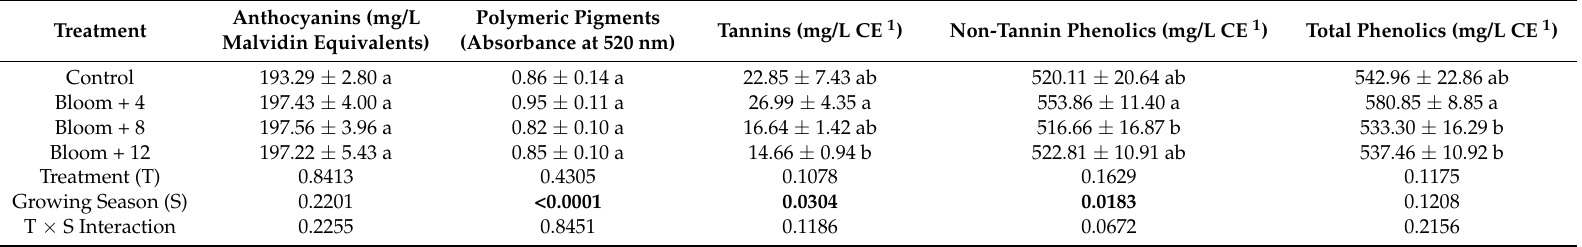
Table 5. Two-way analysis of variance (ANOVA) with interaction showing mean values and p -values of wine phenolic parameters post-malolactic fermentation by cluster thinning treatment. Combined two-year averages followed by standard error of the mean. Also shown are p -values corresponding to main effects and the interaction between treatments and growing season ( n = 3). Different letters within a column indicate significant differences between treatment groups for Fisher’s LSD at p < 0.05. p values below 0.05 are shown in bold